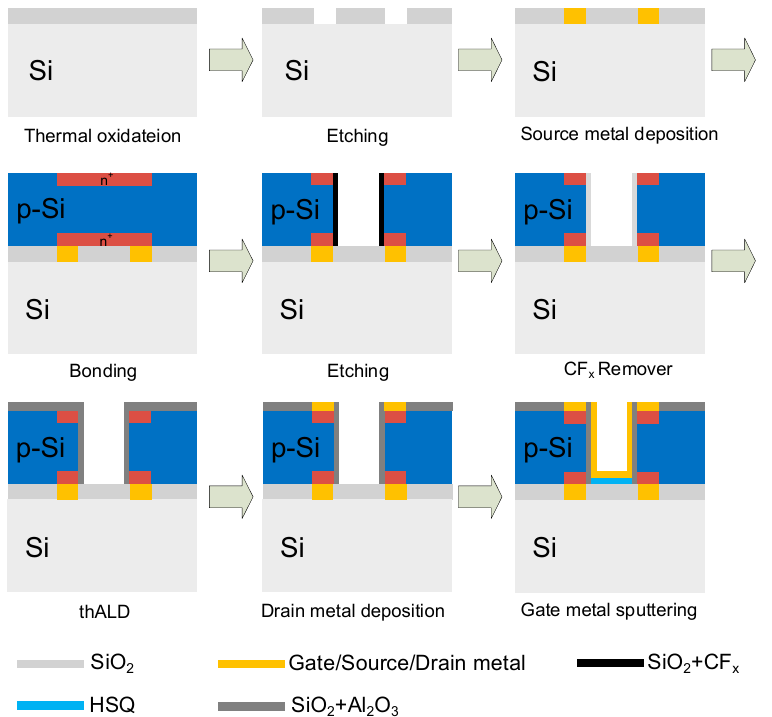
Figure 3. Flowchart of the fabrication process for the proposed vertical transistor.